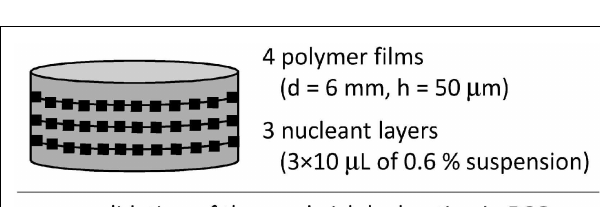
FIGURE 4 | Preparation of three-layer sandwich for study of nucleating activity by DSC